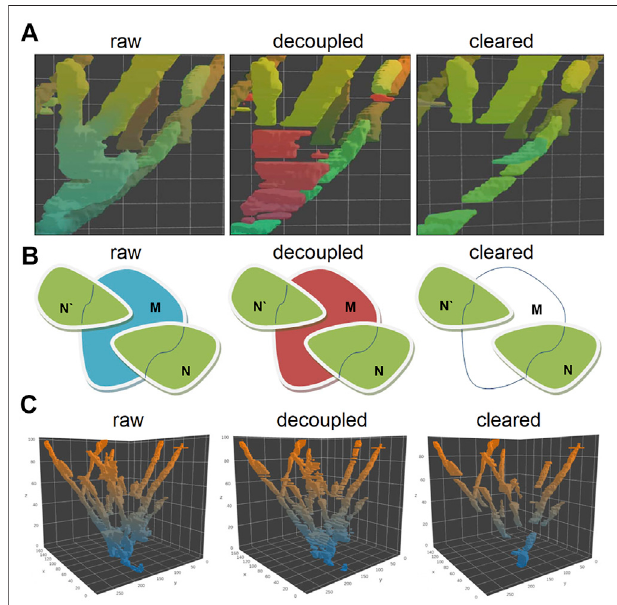
FIGURE 3 | Visualization of the plus end comet collision in a spatial – temporal (A) and 2D projection of the collision point (B) , before decoupling and after removing all non-comet objects. The decoupling algorithm compares the topological sets of XY coordinates with each other in T n – T n+1 for a given tree object of objects N and N ′ shift toward each other along the Z -axis form merged intersection object M at a certain point of time. The merged tracks of comets M belong to the T n+1 plane, track N, and trackN ′ belongtoT n .ThisobjectcanberepresentedasasetMinT n+1 andas the sets N and N ′ in T n for the same X-Y coordinates. So, if M ∩ N ′ and M ∩ N arenon-emptysetsandifthenumberofthesenon-emptysetsare2orgreater (for a greater number of comets), this means collision of comets occurs. For such cases, M set is removed from the voxel cloud and splits into several pieces. The 3D visualization of the decoupling process of the topological object point cloud (C) : after decoupling of the comet collision, event the solid “ tree ” shape object converts into a set of separate comet